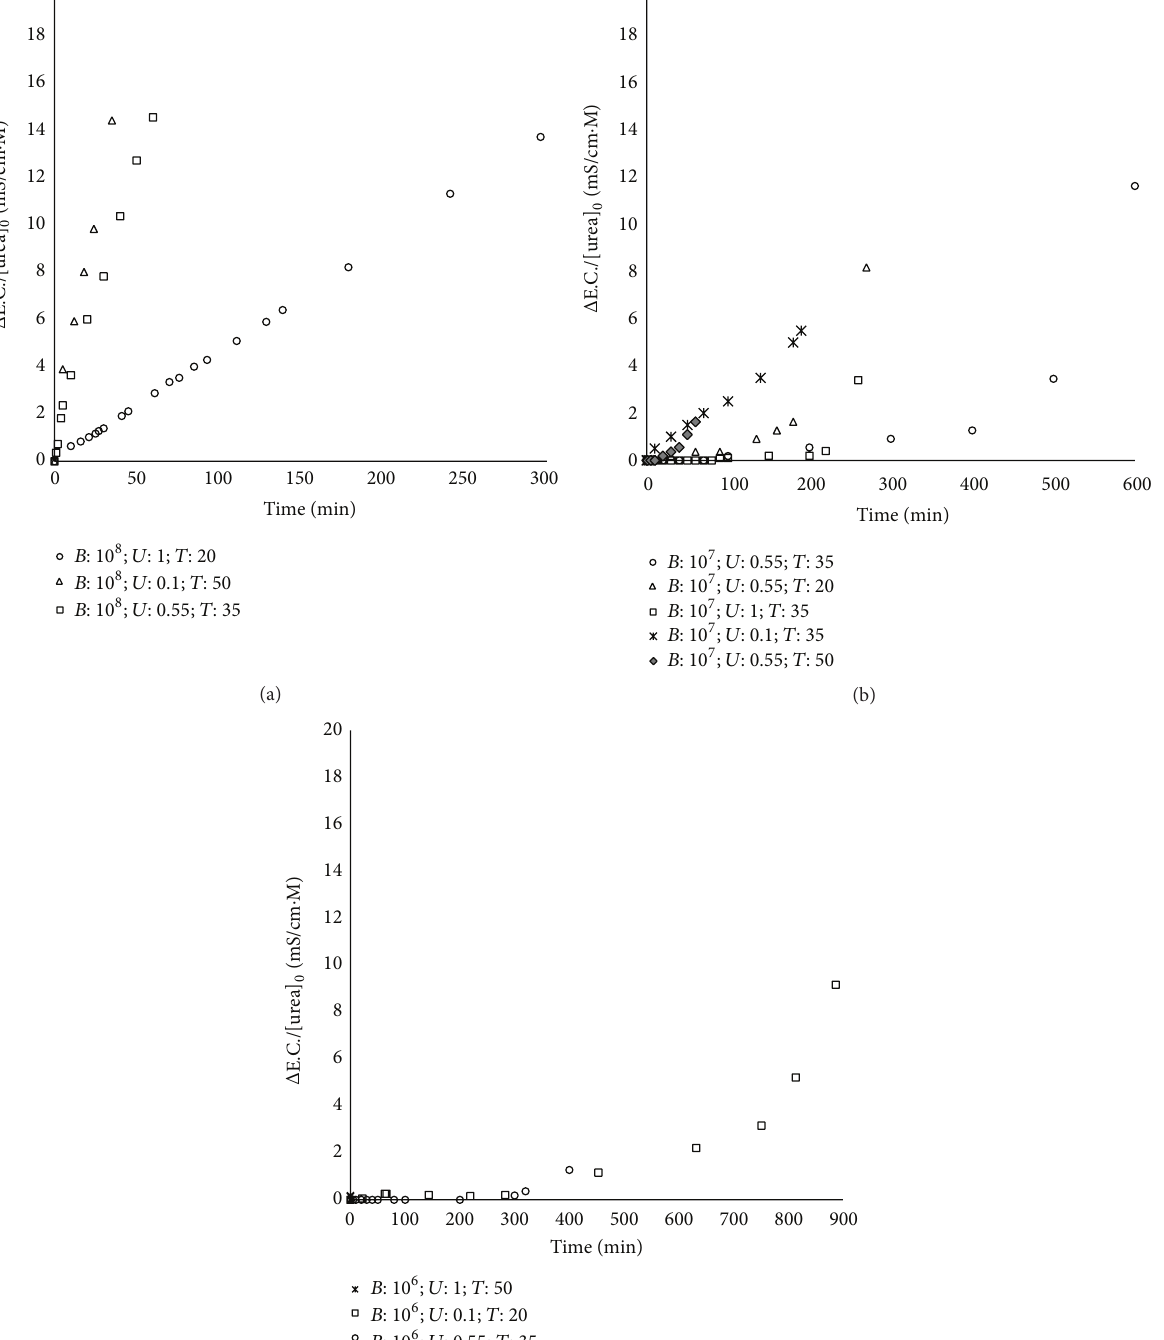
(c) cells/mL initial cell